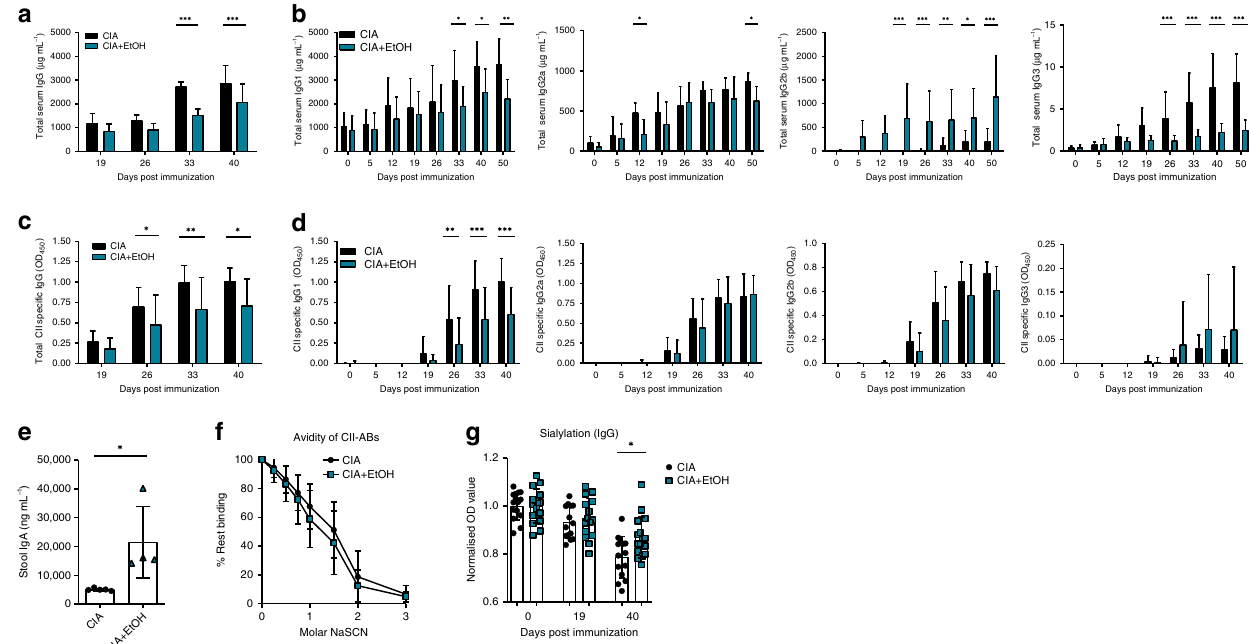
Fig. 3 Alcohol exposure alters dynamics of IgG response. a , b Time course of the levels of total serum IgG (CIA, n = 7, CIA + EtOH, n = 5 mice) a and IgG subclasses b from mice induced for CIA and exposed to vehicle (CIA, n = 6 mice) or alcohol (CIA + EtOH, n = 6 mice). c , d Time course of the levels of collagen type 2 (CII)- speci fi c serum IgG (CIA, n = 7, CIA + EtOH, n = 6 mice) c and IgG subclasses d from mice induced for CIA and exposed to vehicle (CIA, n = 6 mice) or alcohol (CIA + EtOH, n = 6 mice). e Stool IgA levels of mice induced for CIA and exposed to vehicle (CIA, n = 5 mice) or alcohol (CIA + EtOH, n = 5 mice). f Avidity of CII speci fi c antibodies determined with NaSCN elution (CIA, n = 7 mice, CIA + EtOH, n = 5 mice). g Sialylation status of total serum IgG from mice induced for CIA and exposed to vehicle (CIA, n = 6 mice) or alcohol (CIA + EtOH, n = 6 mice). N number represents number of animals used per experiment. Data shown from one of three independent experiments and expressed as mean ± SD. Statistical difference was determined by two-way ANOVA ( a , b , c , d , f , g ) or Students two-tailed t -test ( e ). * p < 0.05; ** p < 0.01; *** p <